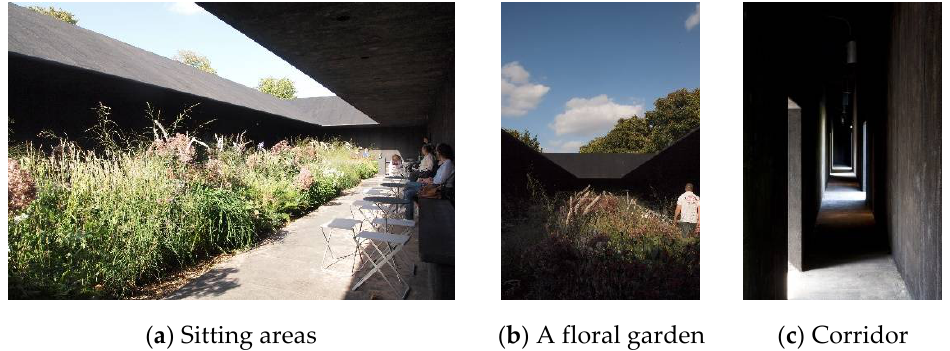
Figure 3. Peter Zumthor, Serpentine Pavilion, 2011. (Photos ( a , b ): author. Photo ( c ): John Offenbach).